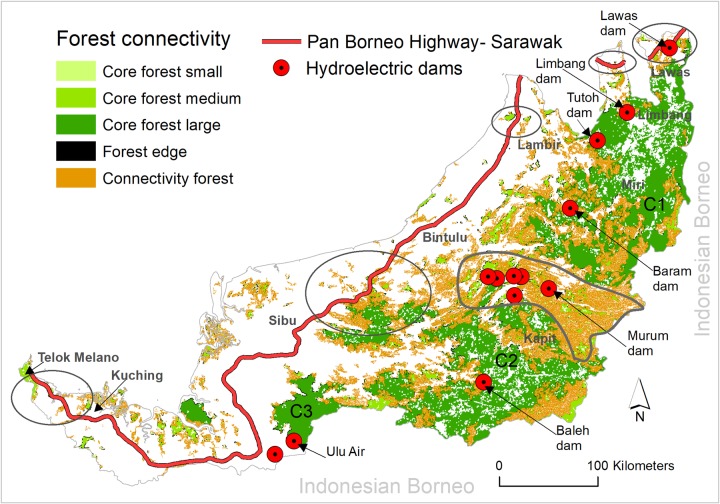
The Pan-Borneo Highway, hydroelectric dam projects and forest connectivity in Sarawak, Malaysia.C1, C2, and C3 indicates the three largest continuous core forest blocks. Circular highlights along the highway indicate the critical road segments threatening forest connectivity. Circular highlight in kapit region indicates the most important connectivity forest which will be impacted by the hydroelectric dams. Small, medium and large core forest indicates core forest block with an area of < 1,000 ha, 1,000 to 25,000 ha, and > 25,000 ha respectively.